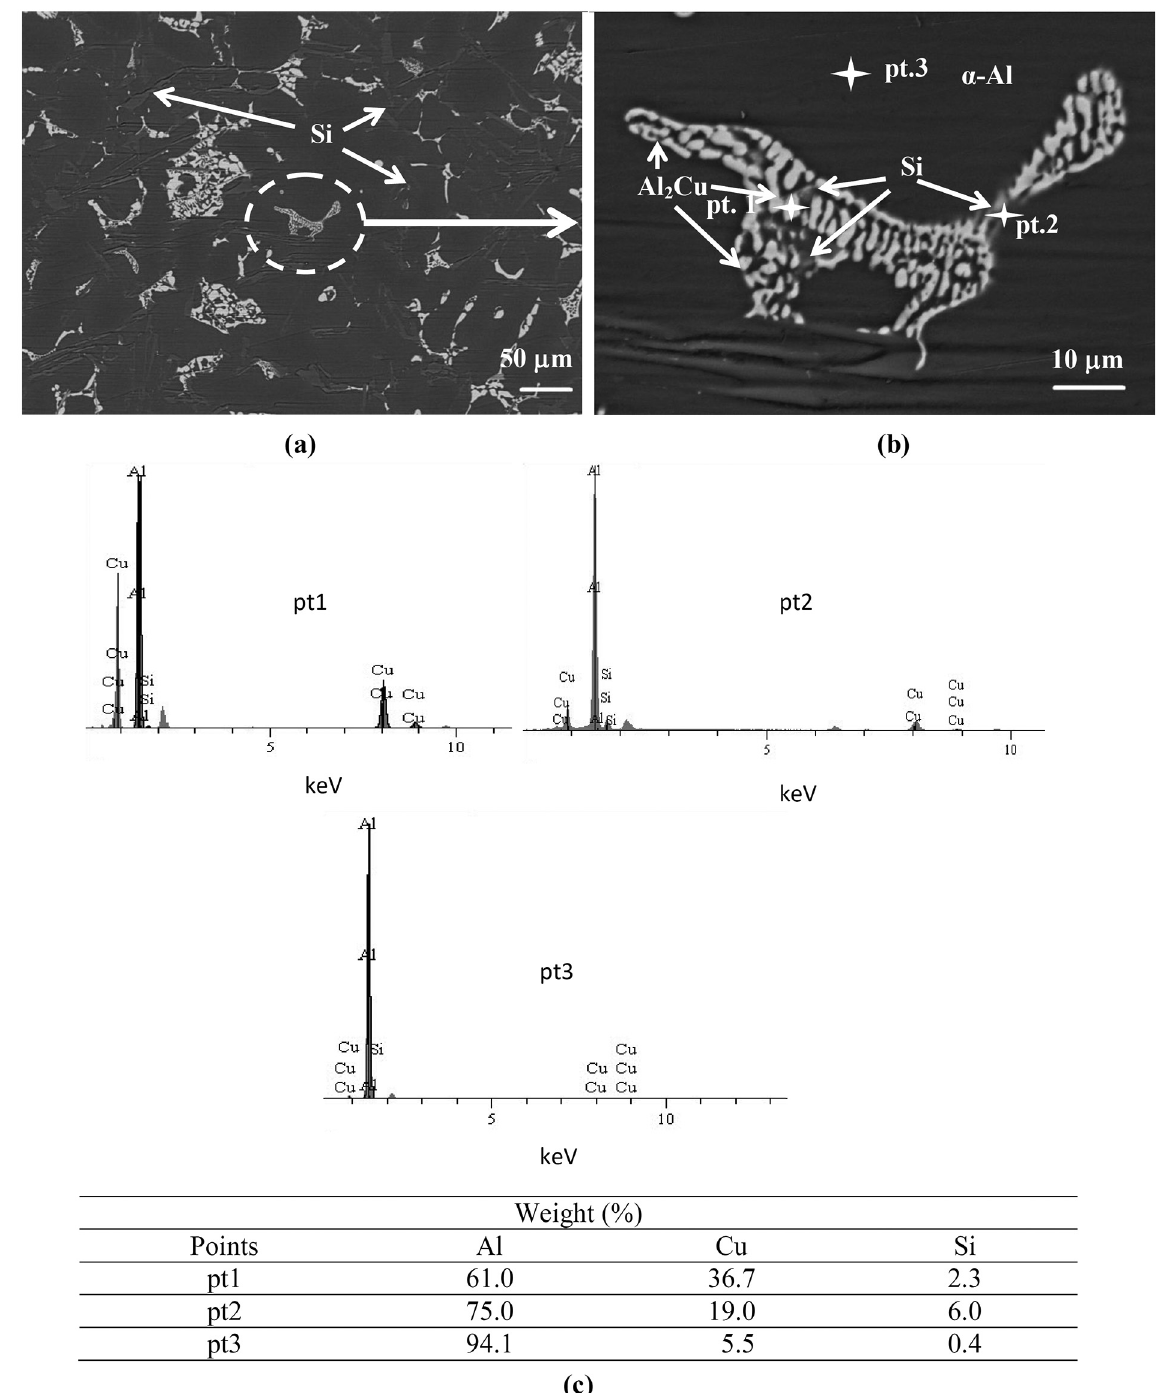
Figure 6 - Typical SEM micrograph and EDAX patterns of a Al-6wt.%Cu-8wt.%Si alloy sample at 40 mm (V = 302.3 μ m) from the cooled surface of the casting for Al-6wt.%Cu-8wt.%Si alloy: ( a ) Accelerating Voltage: 20 0.91 K/s and λ 1 kV and Magni fi cation: 200; ( b ) Accelerating Voltage: 20 kV and Magni fi cation: 1500; ( c ) EDAX patterns and the corresponding chemical